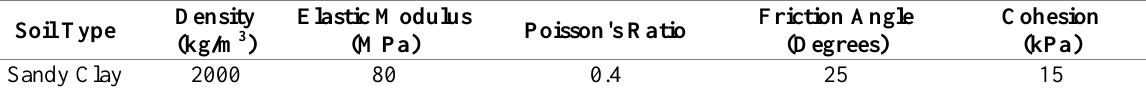
Fig. 4. Deformed mesh during pile penetration at depths of: (I) 3 m, (II) 6 m, (III) 9 m Table 1. Soil properties used by Masoumi et al. (2009)